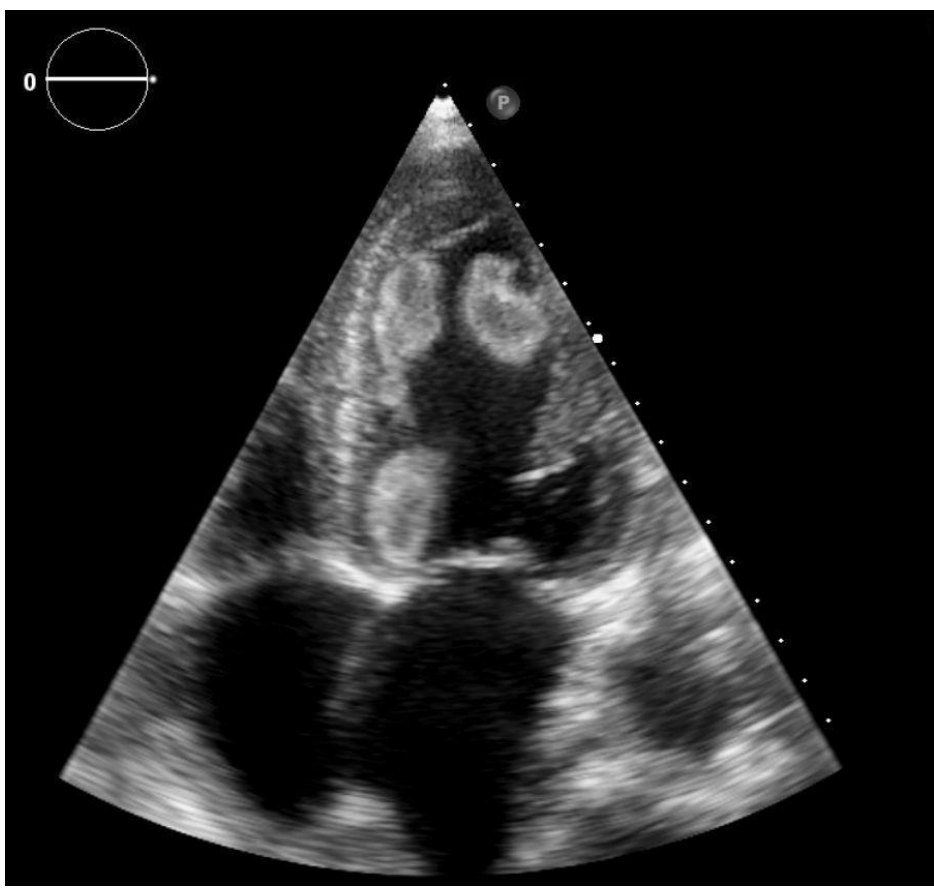
Figure 1. 2D transthoracic echocardiography, apical four chamber view—the left ventricular cavity is filled by multiple thrombi: apical-septal (AS), -lateral (AL) and basal-infero-septal (BIS).